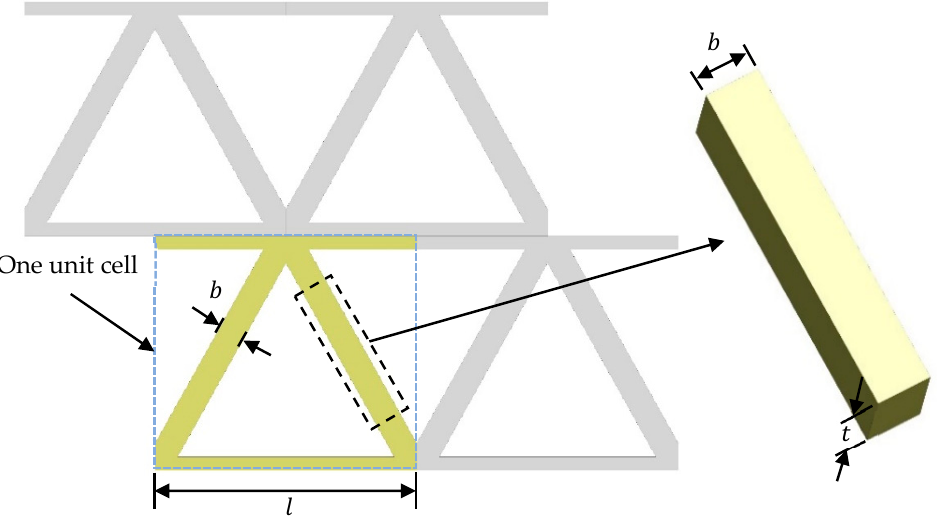
Figure 5. A lattice structure with triangular unit cells.